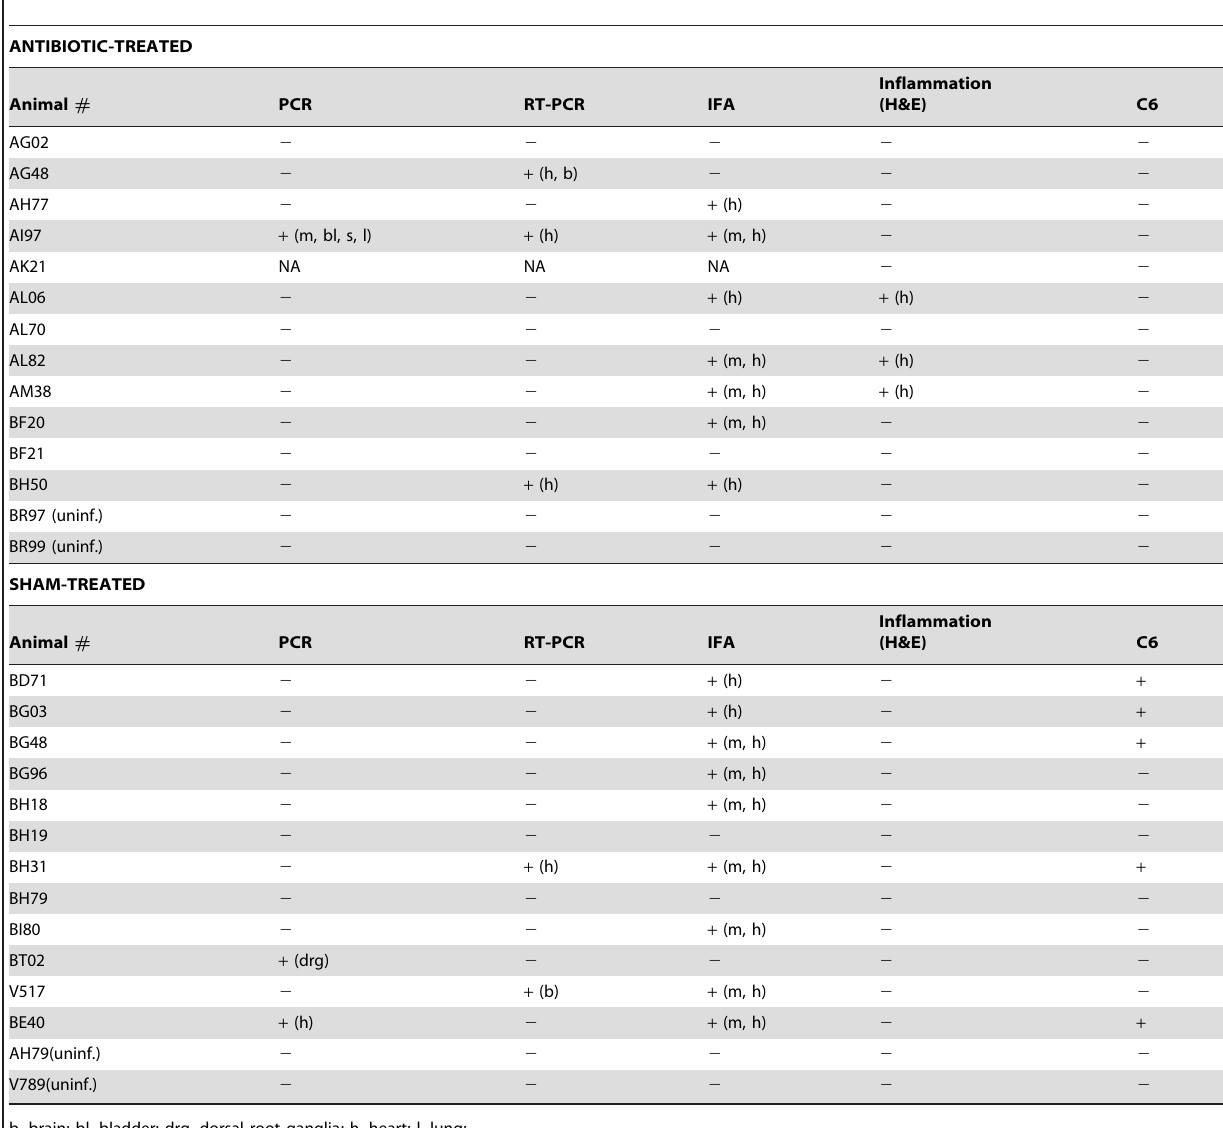
Table 1. Detection of B. burgdorferi DNA (PCR), antigen by immunofluorescence assay (IFA), anti-C6 serum antibody (C6), B. burgdorferi RNA (RT-PCR), and inflammatory lesions (by Hematoxylin and Eosin stain (H&E)) in all animals at postmortem, 6 to 12 months after the end of the antibiotic treatment (Experiment